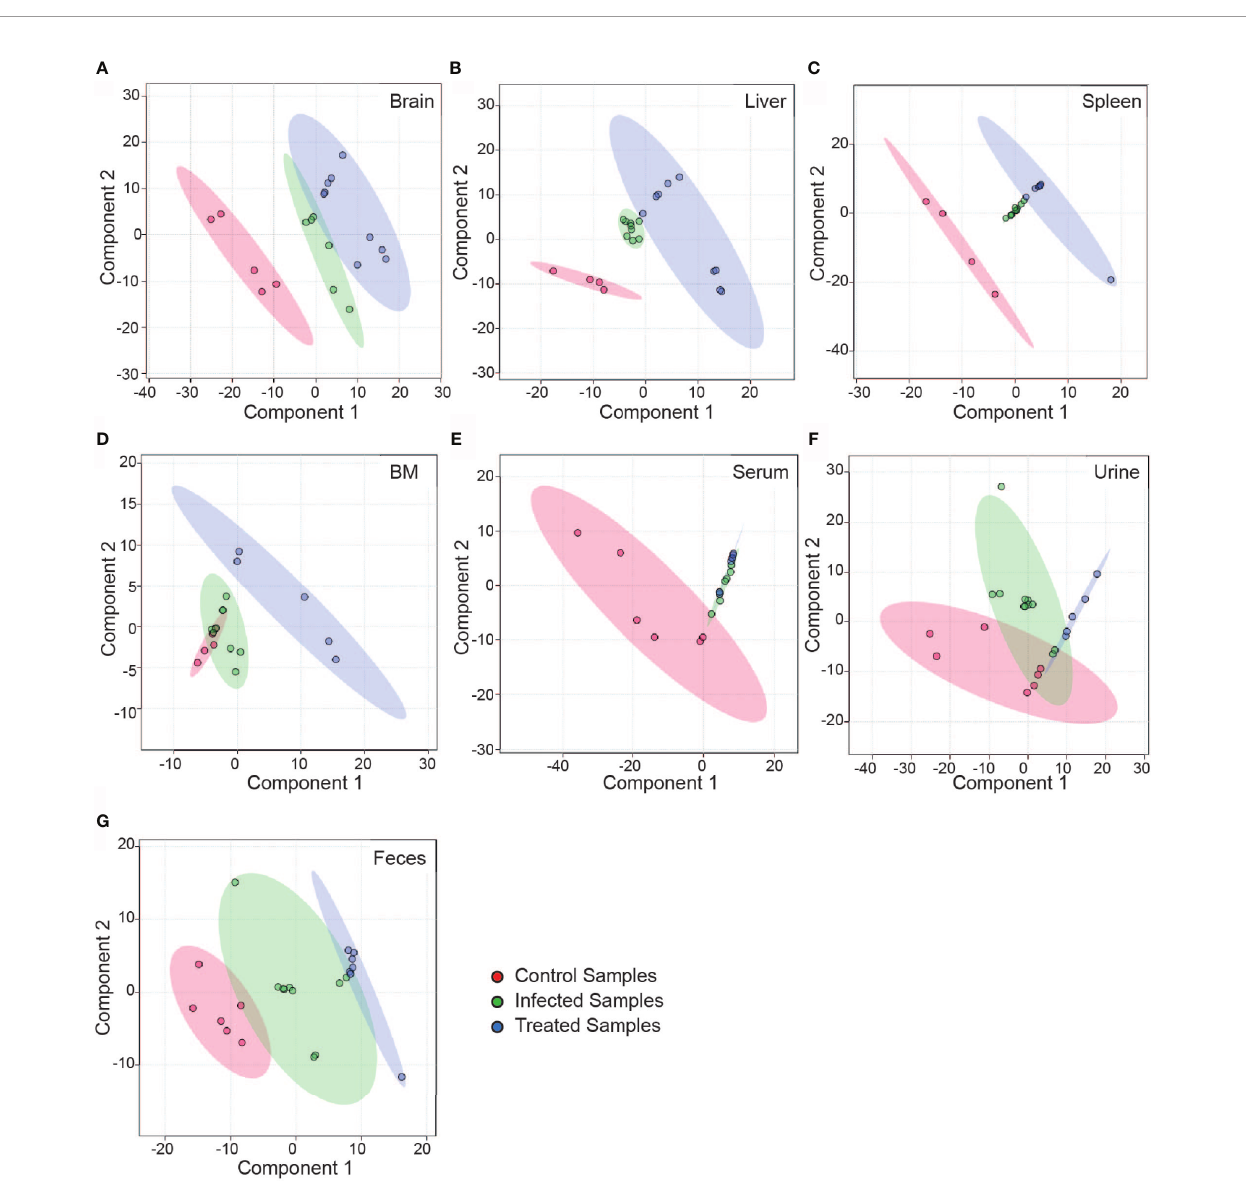
FIGURE 3 | Partial Least Square Determinant Analysis (PLS-DA). A supervised classi fi cation method that uses group labels to maximize the separation between groups. Here, we have shown the separation of control (red), infected (green) and treated (blue) groups in different tissue and bio fl uid samples using a 2D score plot of the fi rst two components. Separation of the different groups are represented in a 2D score plot with 95% con fi dence ellipse regions based on the data points for individual groups in different tissues — (A) Brain, (B) Liver, (C) Spleen, (D) ; Bone marrow and bio fl uids — (E) Serum, (F) Urine, and (G) Feces. In (D) and (E) the overlap seen among the groups are on different spatial planes as visualized in 3D score plot (data not